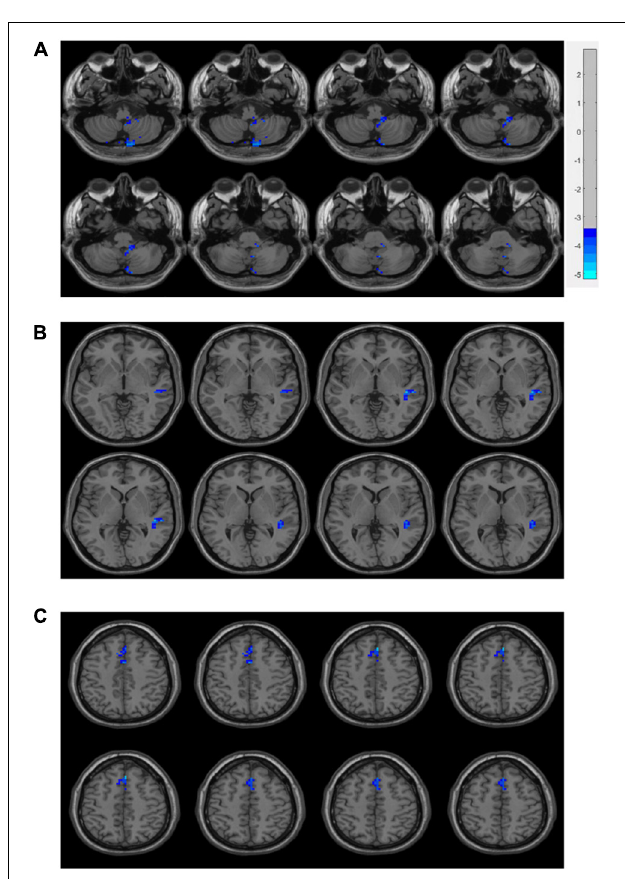
FIGURE 3 | Brain regions of voxel-wise concordance differences between PD patients and HCs: the cerebellum posterior lobe (CPL) and cerebellar tonsil (CTO) (A) , superior temporal gyrus (STG) (B) , and supplementary motor area (SMA) (C) .